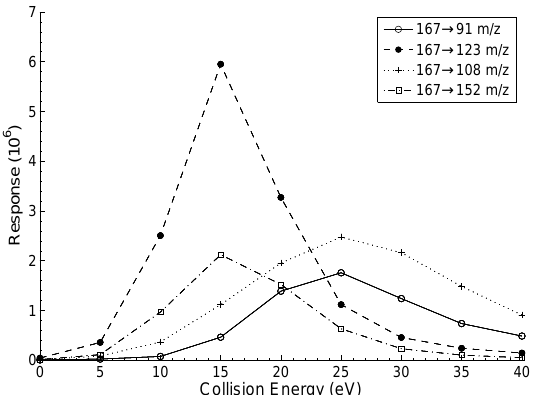
Figure 2. Instrument response to a 1ppm vanillic acid solution at varying collision energies using the 167 → 91 m/z , 167 → 123 m/z , 167 → 108 m/z , and 167 → 152 m/z mass